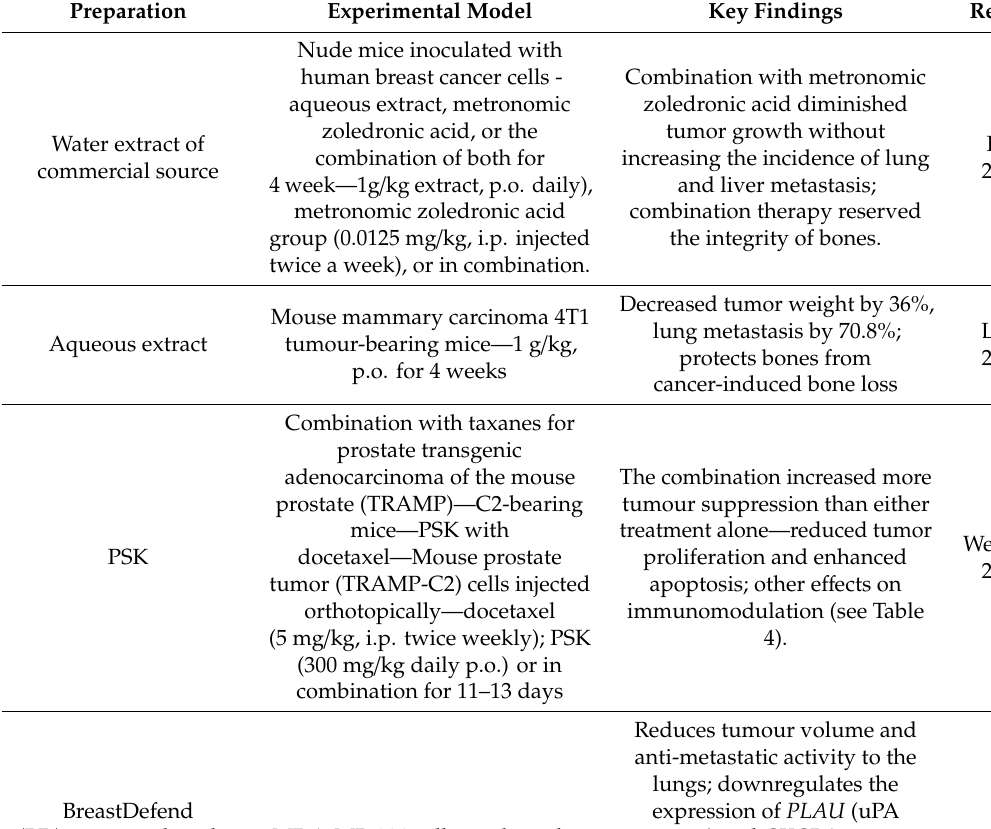
Table 2. Direct antitumour e ff ect in vivo.